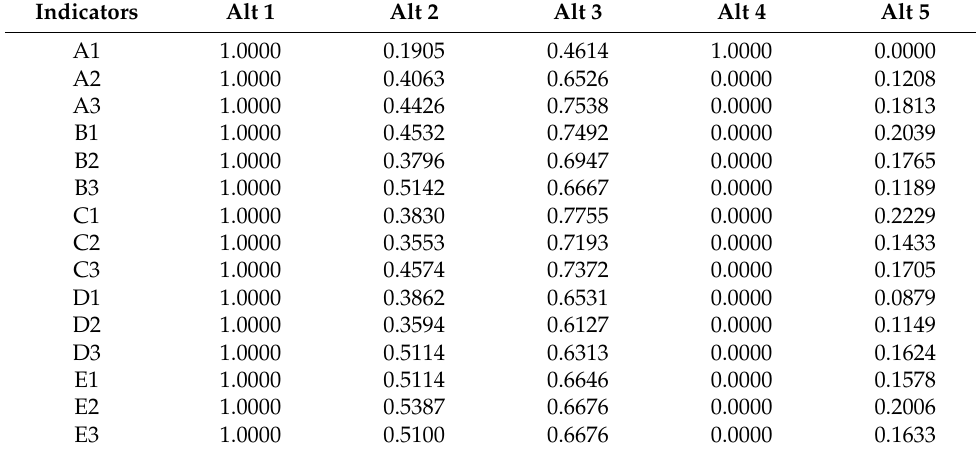
Table 15. Deviation sequences.